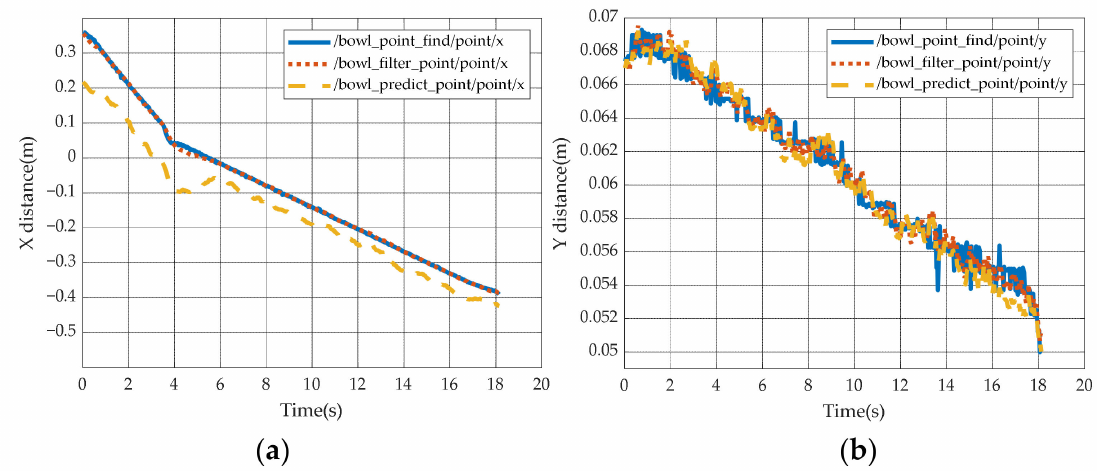
Figure 16. The prediction effect of PF in actual by rqt_plot: ( a ) is the effect of PF on the x-axis; ( b ) is the effect of PF on the y-axis.